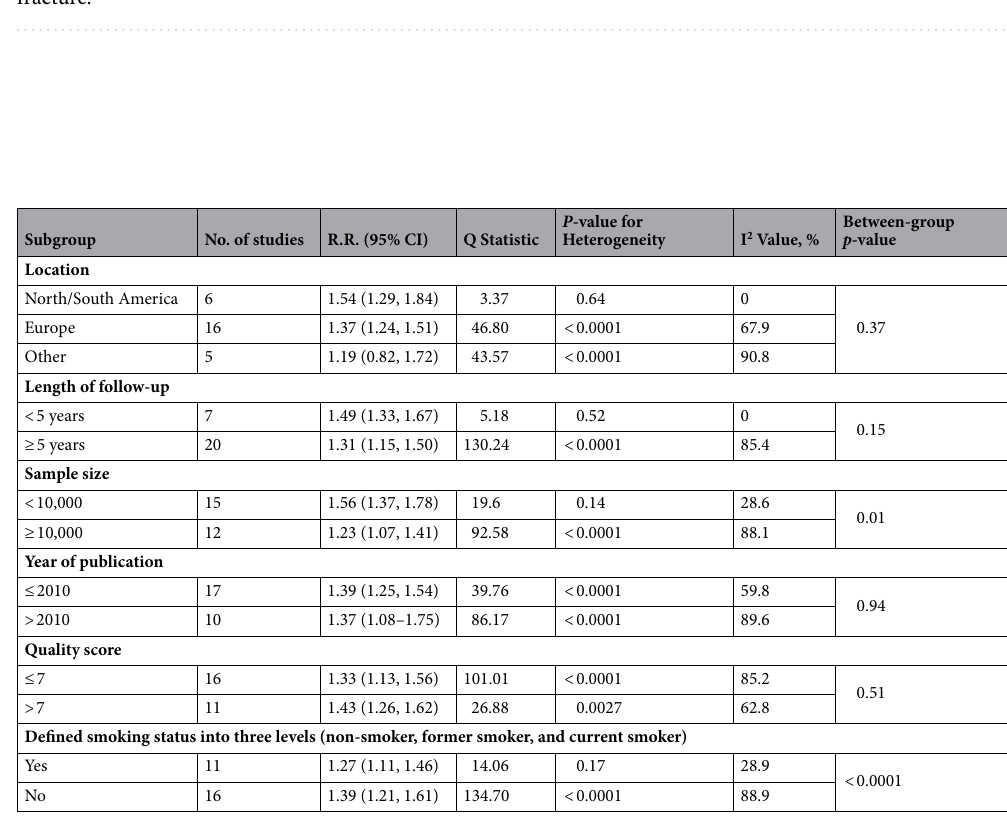
Between-group p